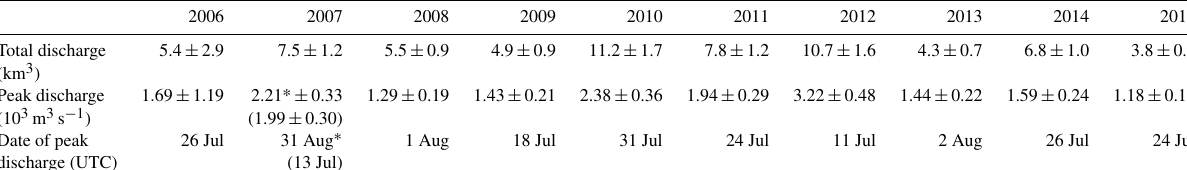
Table 1. Watson river discharge values with uncertainty. Values marked by ∗ originate from an ice-dammed lake drainage event.